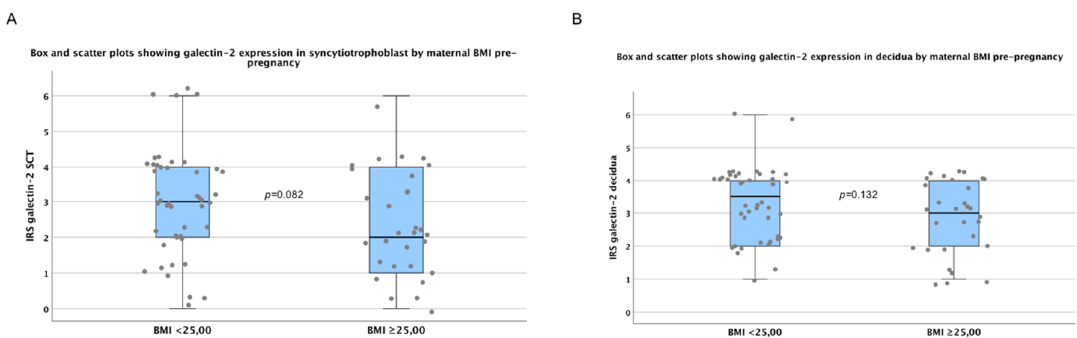
Figure 4. Galectin-2 expression by maternal body mass index (BMI) pre-pregnancy. There was no significant difference between the groups. For detailed plot explanation see Figure 1.